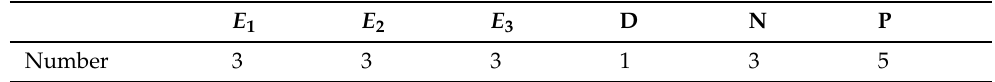
Table 1. Number of agents for each category.